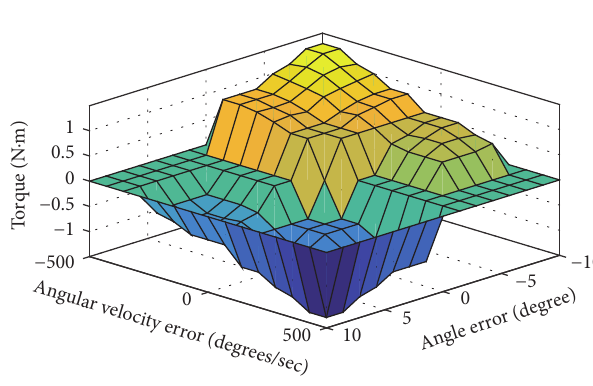
Figure 6: Control surface for the first controller.